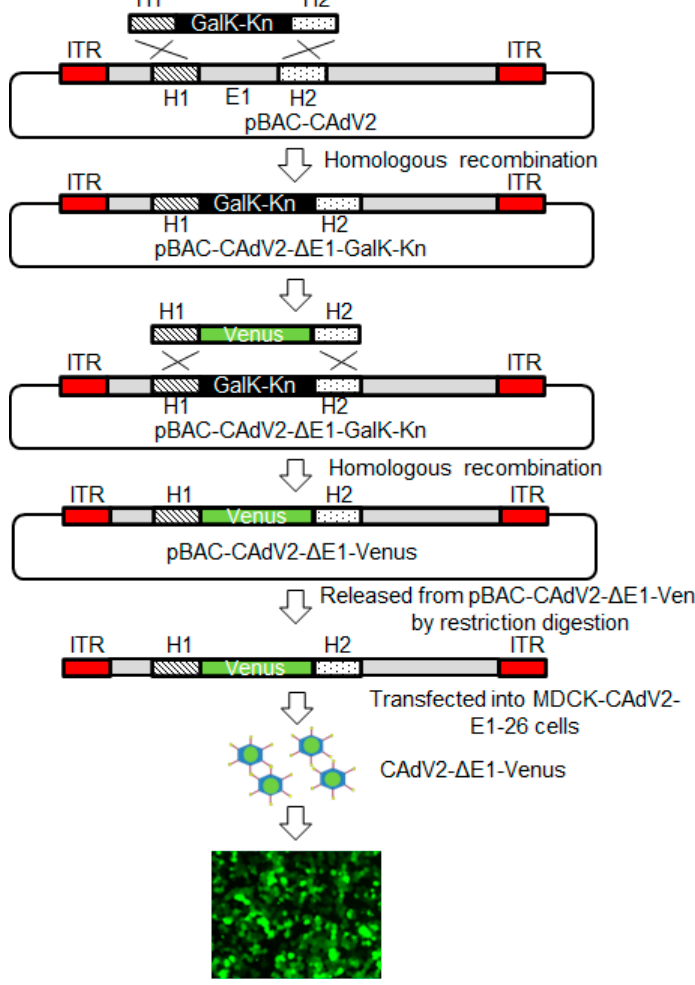
Figure 4. Generation of the E1-deleted CAdV2 mutant. The E1 region of pBAC-CAdV2 was replaced with the Venus expression cassette. The galK and kanamycin resistance gene ( galK-Kn ) expression cassette, flanked by homologous region 1 (H1) and region 2 (H2), was generated by PCR and introduced into SW102 cells harboring pBAC-CAdV2. After homologous recombination, cells were selected by GalK and Kn, whereupon those harboring pBAC-CAdV2- ∆ E1-GalK-Kn were obtained. The Venus expression cassette flanked by H1 and H2 was generated by PCR and introduced into the SW102 cells harboring pBAC-CAdV2- ∆ E1-GalK-Kn. After homologous recombination, cells were selected by GalK, whereupon those harboring pBAC-CAdV2- ∆ E1-Venus were obtained. CAdV2- ∆ E1-Venus was rescued through the transfection of restriction enzyme-digested pBAC-CAdV2- ∆ E1-Venus into MDCK-CAdV2-E1-26 cells. After the MDCK cells had been infected with CAdV2- ∆ E1-Venus at an MOI of 0.4, Venus expression was observed by fluorescence microscopy. The image was taken at 24 h post-infection.